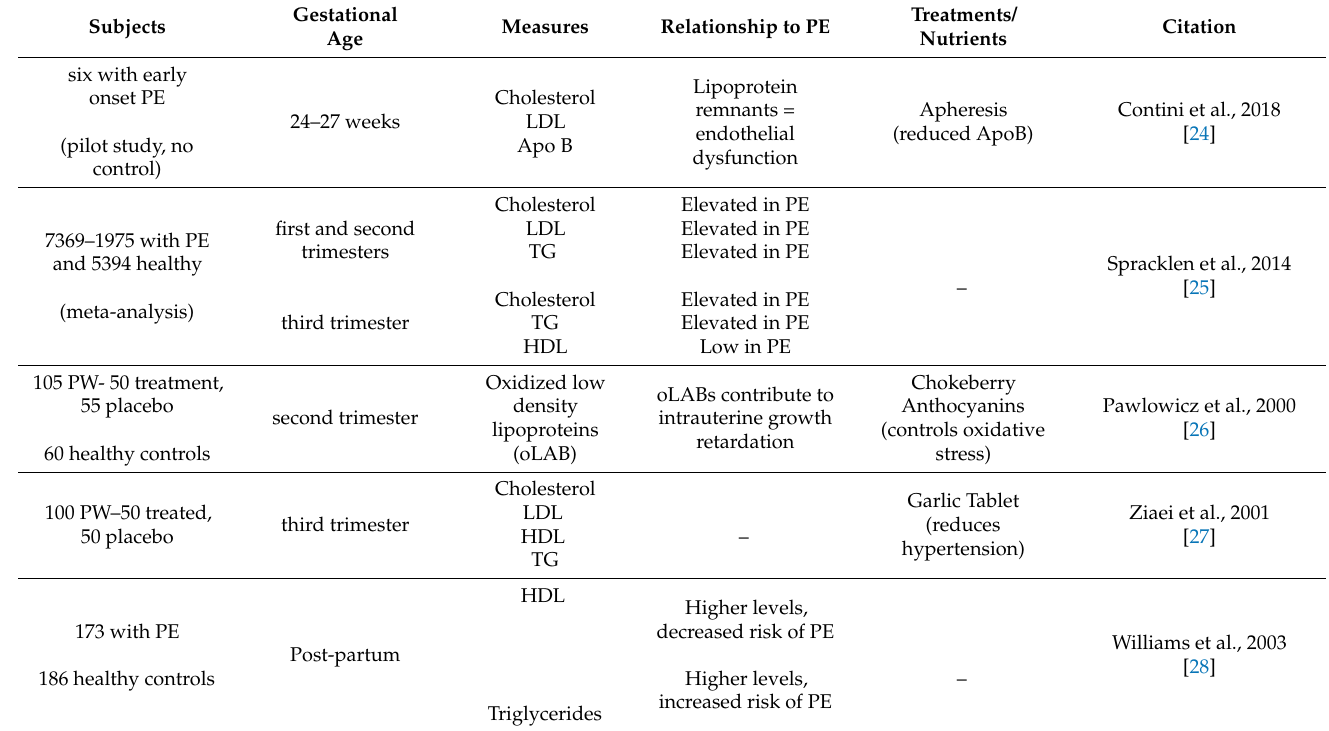
Table 1. Human studies providing evidence for a link between dyslipidemia and